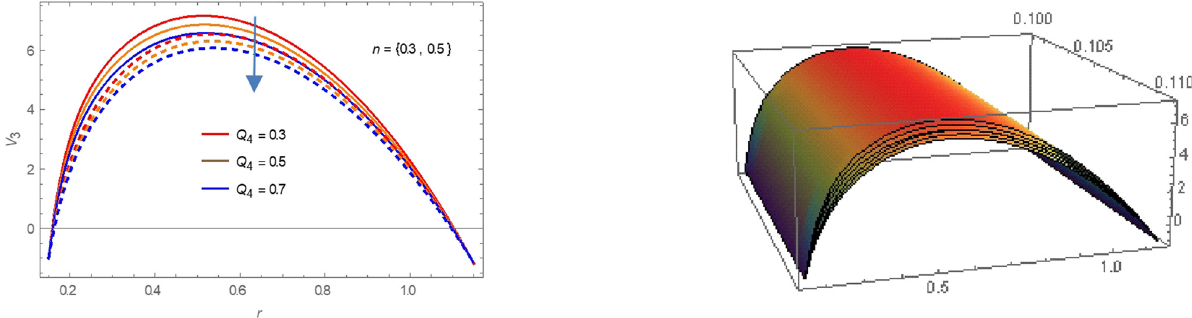
Figure 5: Distribution of velocity for di ff erent values of n and Q 4 with W